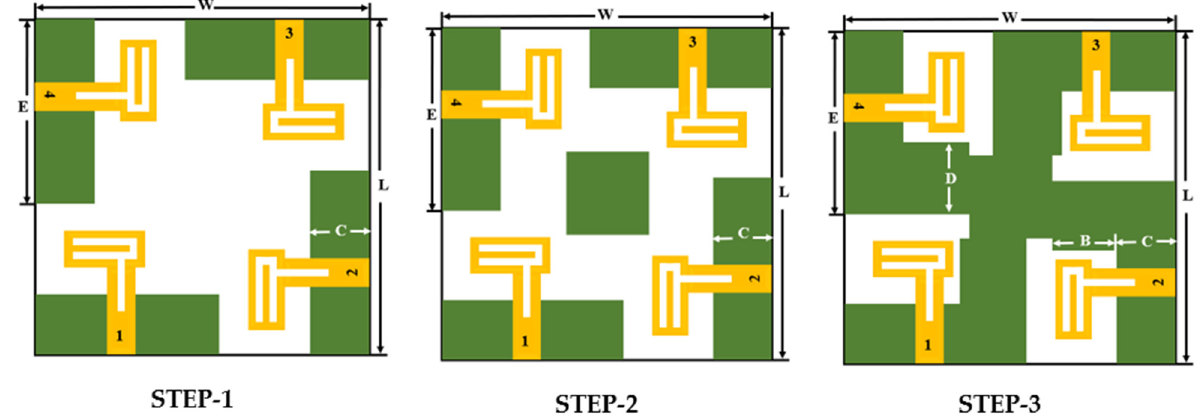
Figure 4. Design evolution of the ground plane structure for the proposed antenna.